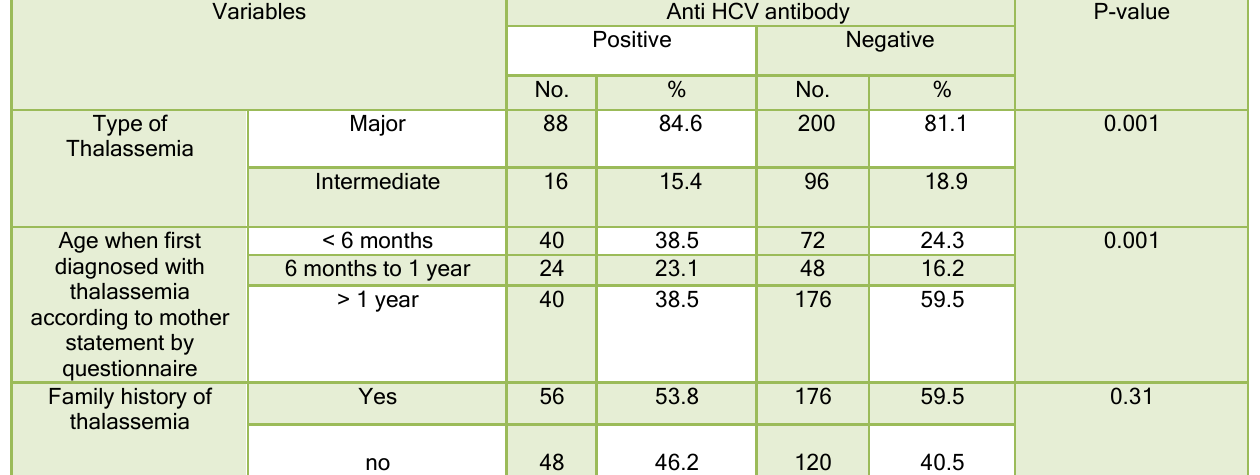
Table 2: The Prevalence of anti HCV antibody according to thalassemia characteristics.